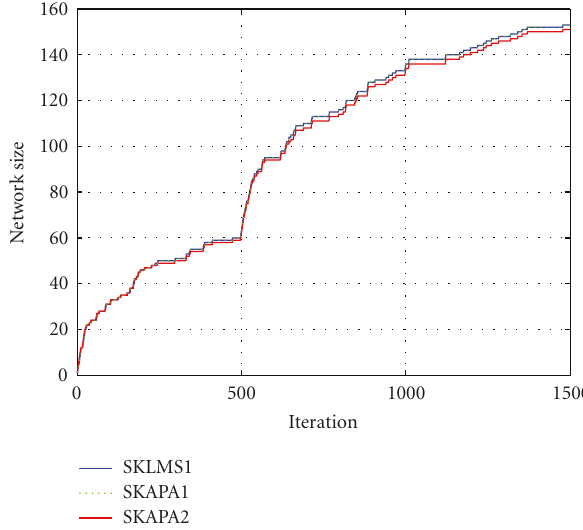
Figure 8: Performance comparison with di ff erent SNR in the nonlinear channel equalization.